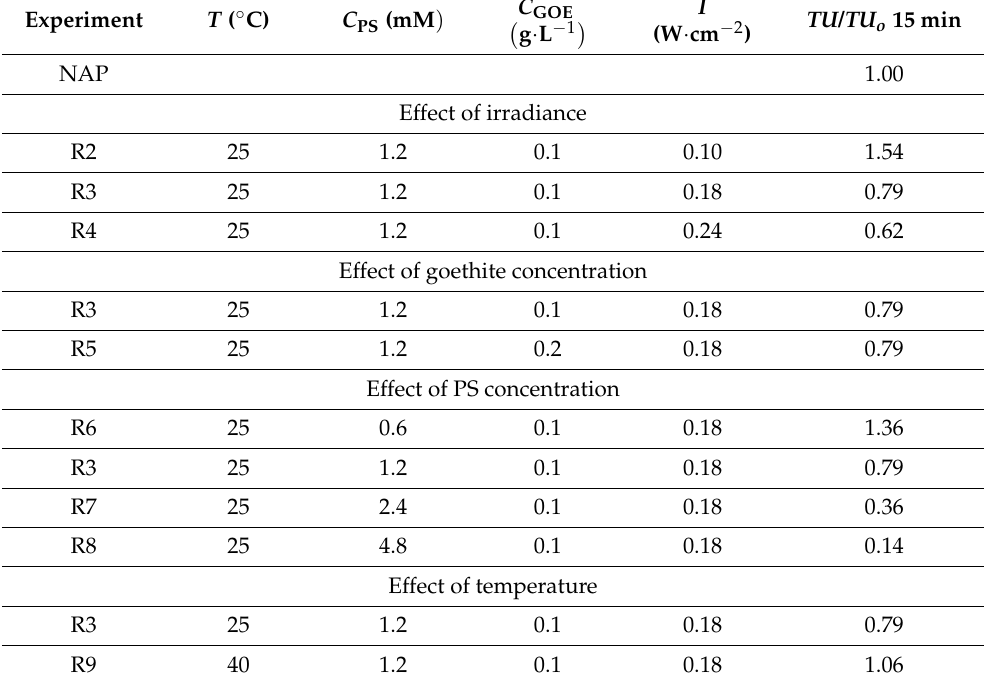
Table 3. Ratio of TU of the reaction samples after 180 min to initial Toxicity ( TU o =